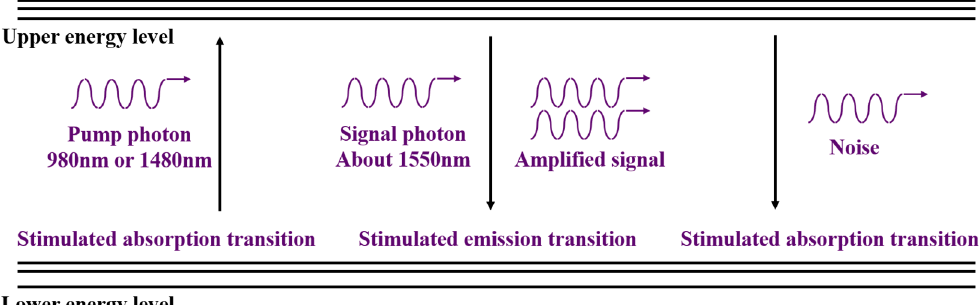
Figure 1. Limited two-level system of erbium-doped fiber